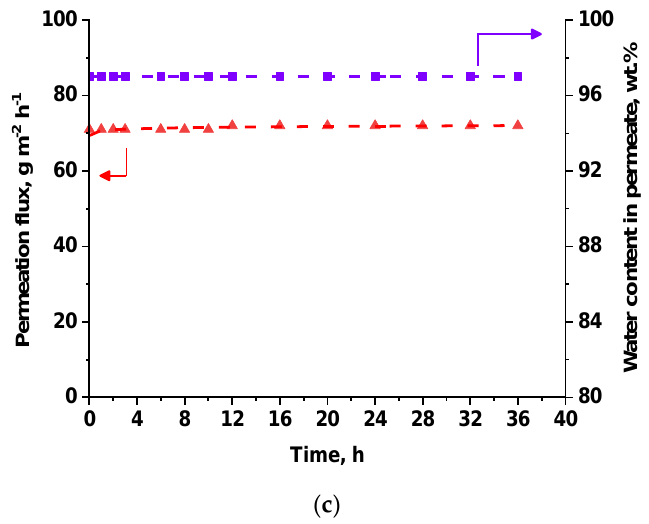
Figure 12. Pervaporation separation performance of PI-DA membrane in dehydrating of isopropanol: ( a ) dependence of permeation flux and water content in permeate on water content in the feed solution isopropanol/water (feed temperature is 25 °C); ( b ) dependence of permeation flux and water content in permeate on feed solution temperature (feed solution 88 wt.% isopropanol/12 wt.% water); ( c ) dependence of permeation flux and water content in the feed solution on time of per- vaporation.